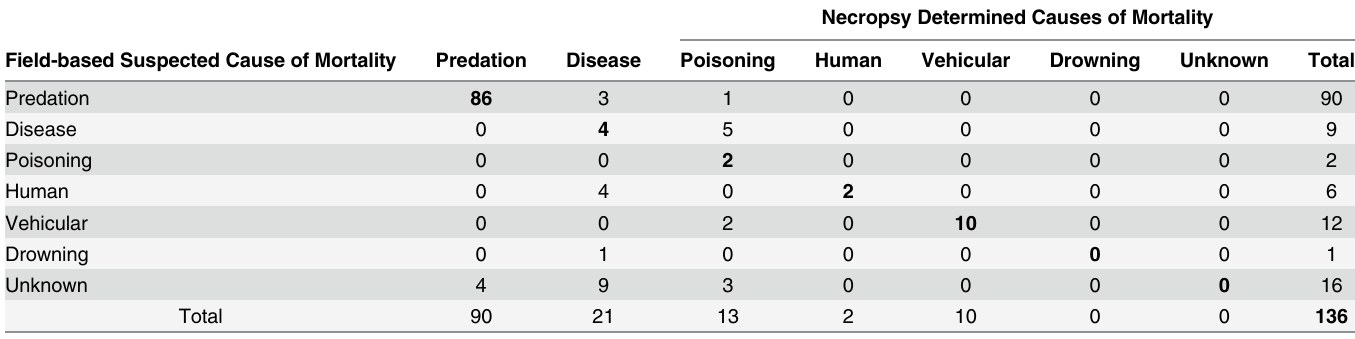
Table 3. Field-based causes of mortality determined by field evidence alone and necropsy determined causes of mortality for fishers ( Pekania pennanti ) within the two isolated populations, northern California and southern Sierra Nevada. Data were combined from 2007 to 2012 (n = 136).